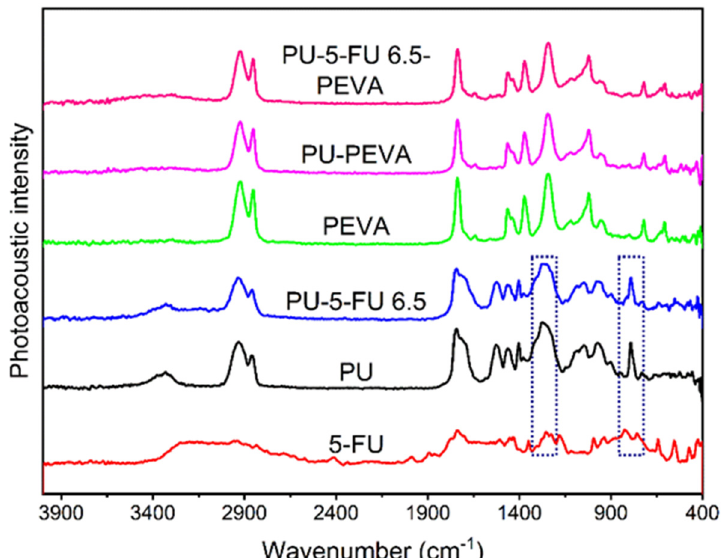
Figure 2. Photoacoustic FT-IR spectra of 5FU and coatings on silicon wafers as indicated. The highlighted regions indicate noticeable peak broadening (left) and peak shoulder (right) resulting from 5FU within the PU coating.